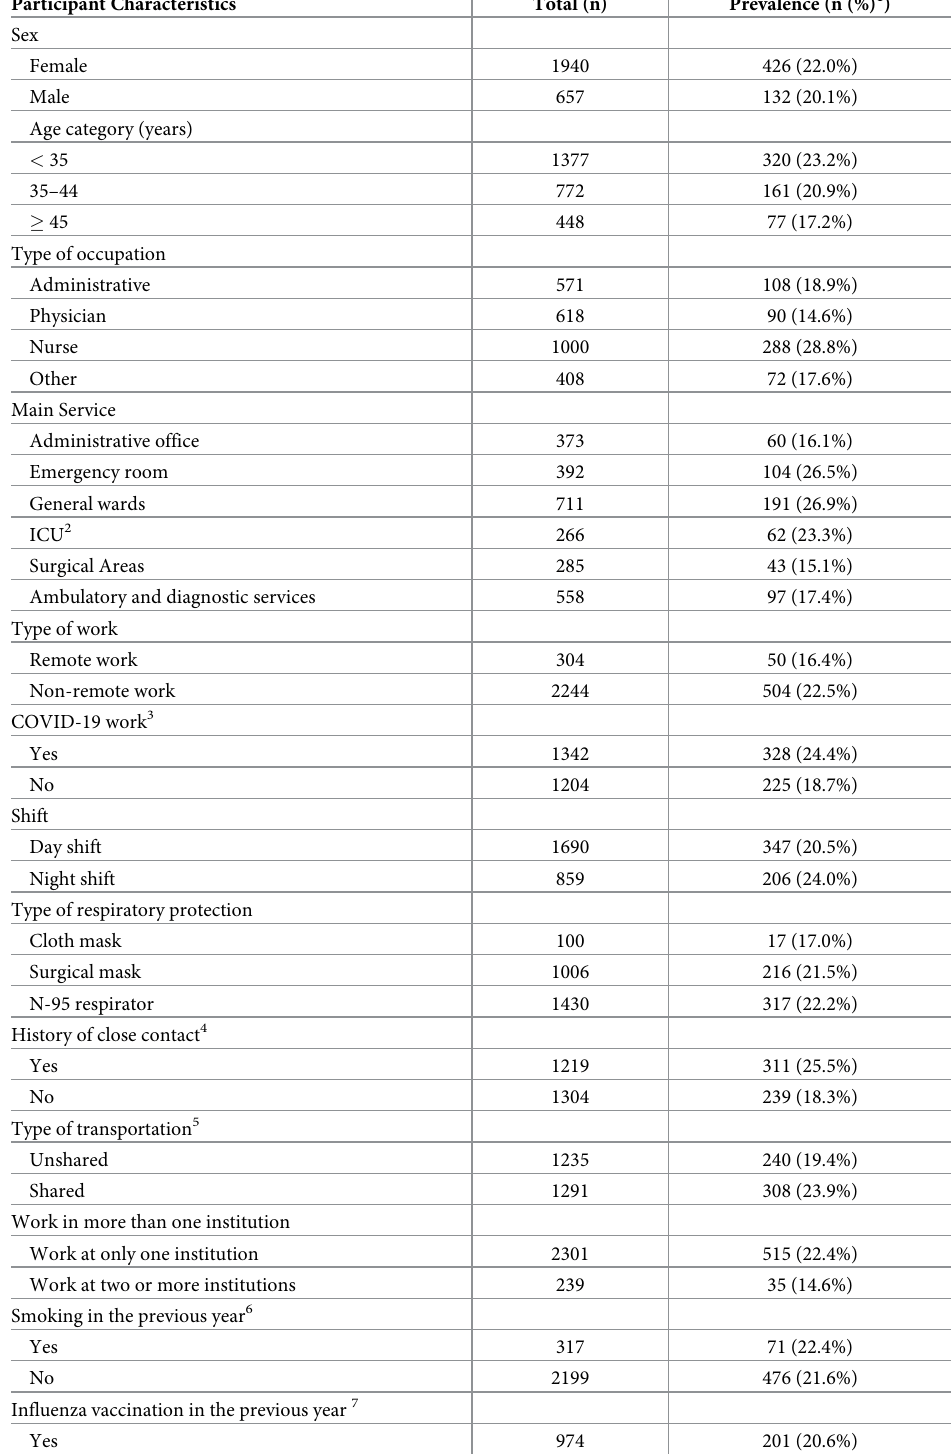
Table 2. Seroprevalence of SARS-CoV-2 by characteristics of the HCWs. Hospital Universitario San Ignacio, November 17, 2020–February 12,